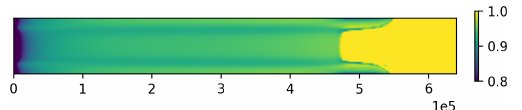
Figure 5. Ratio of basal velocity to surface velocity in steady state of the MISMIP+ scenario computed with the hybrid model.